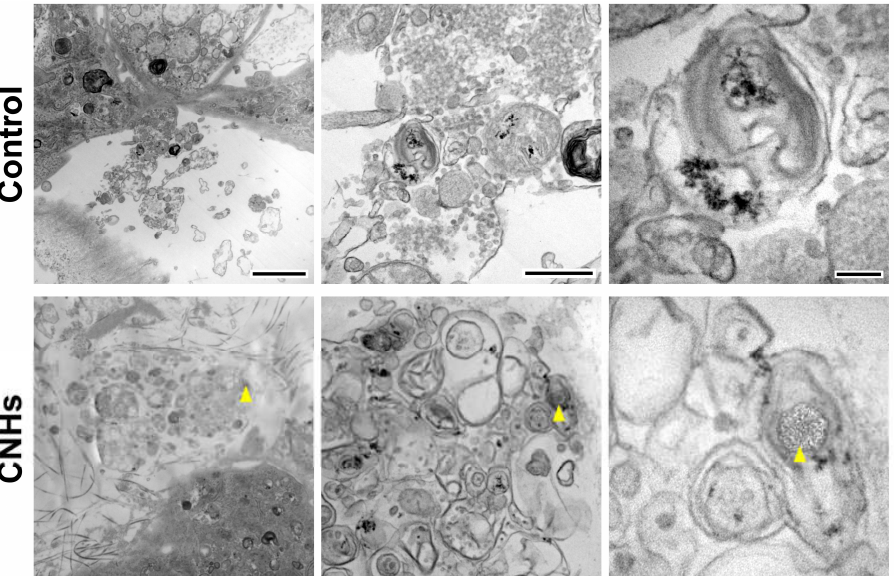
Figure 8. Localization of CNHs encapsulated in extracellular calcified nodules in the OB culture. OBs were exposed to CNHs under calcified conditions. Representative transmission electron microscope images with different magnifications are shown. Arrowheads indicate CNHs. Scale bars: 2 µm ( left panels), 500 nm ( middle panels), and 200 nm ( right panels).